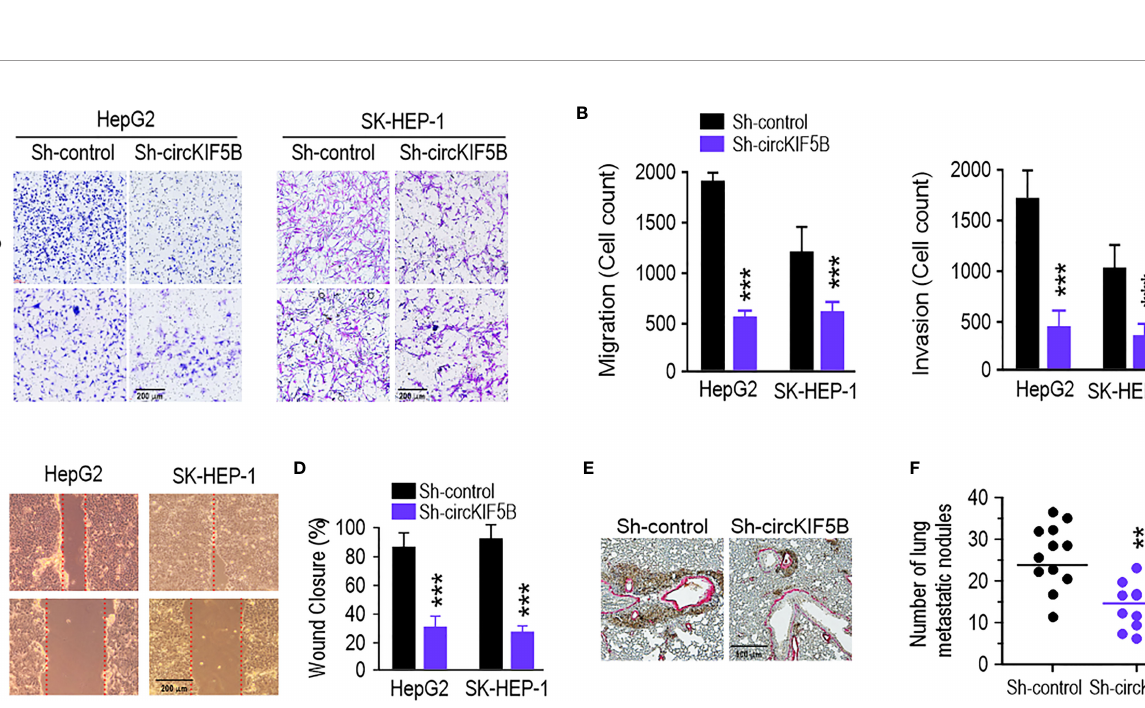
FIGURE 3 | CircKIF5B knockdown depresses HCC cells migration and invasion and tumor metastasis. (A) Repressing circKIF5B suppressed the migration and invasion of HepG2 and SK-HEP-1 cells transfected with control or circKIF5B siRNAs. (B) Colorimetric measurement of panel (A) . (C) The effect of si-circKIF5B on cell migration evaluated by wound healing assay in HepG2 and SK-HEP-1 cells. (D) Quanti fi cation of panel (C) . (E) Lung metastatic colonies in nude mice injected with HepG2 cells stably transfected with si-circKIF5B or control si-RNA. (F) Quanti fi cation of panel (E) . *p < 0.05, **p < 0.01, ***P <